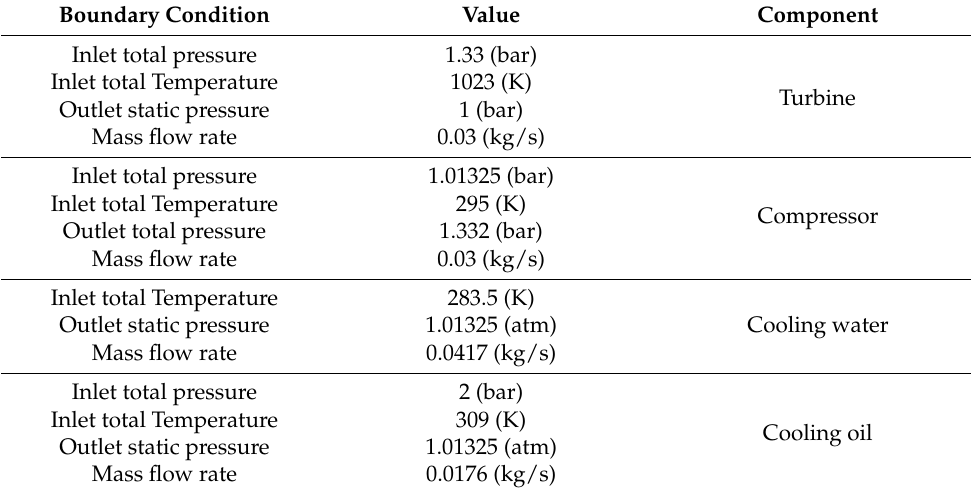
Table 4. MGT components’ boundary conditions.